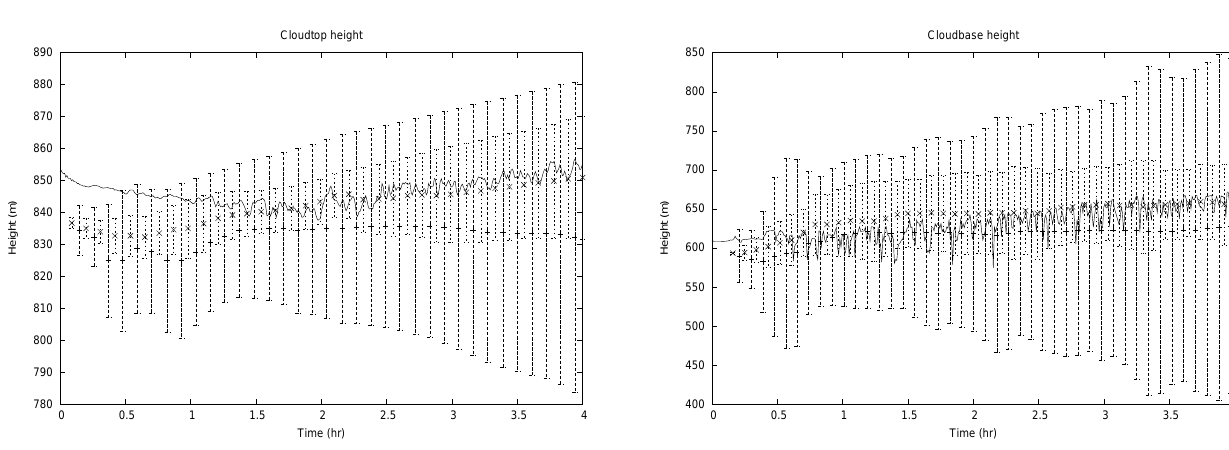
Fig. 3. Cloudbase height of the DYCOMS-II simulation: the solid line shows the results from the 2-D ERM. The inner error bars show the first and third quartiles of the ensemble of LEMs in the Stevens et al. (2005) intercomparison, the outer error bars shows the maxi- mum and minimum values of the